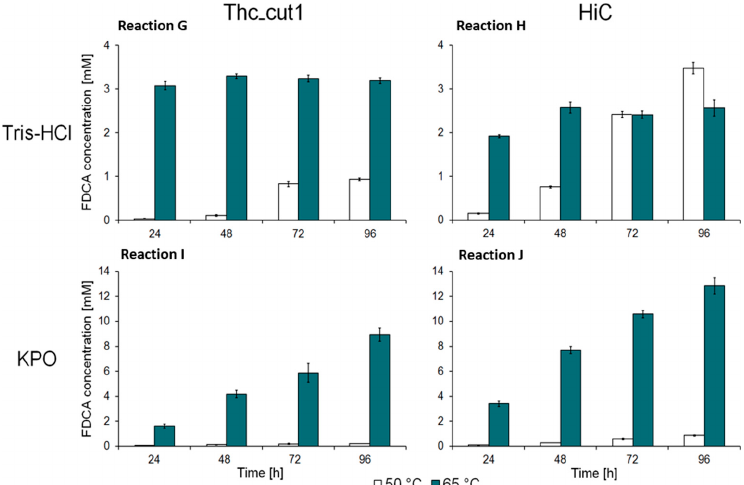
Figure 2. Enzymatic hydrolysis of amorphous PEF films. Time course reaction showing the released 2,5-furandicarboxylic acid (FDCA) for the enzymatic hydrolysis performed at 50 (white bars) and 65 °C (green bars) with Thc_cut1 (reaction G, reaction I) and HiC (reaction H, reaction I) in 0.1 M Tris-HCl pH 7 (reaction G, reaction H) and 1 M KPO pH 8 (reaction I, reaction J). No release products were